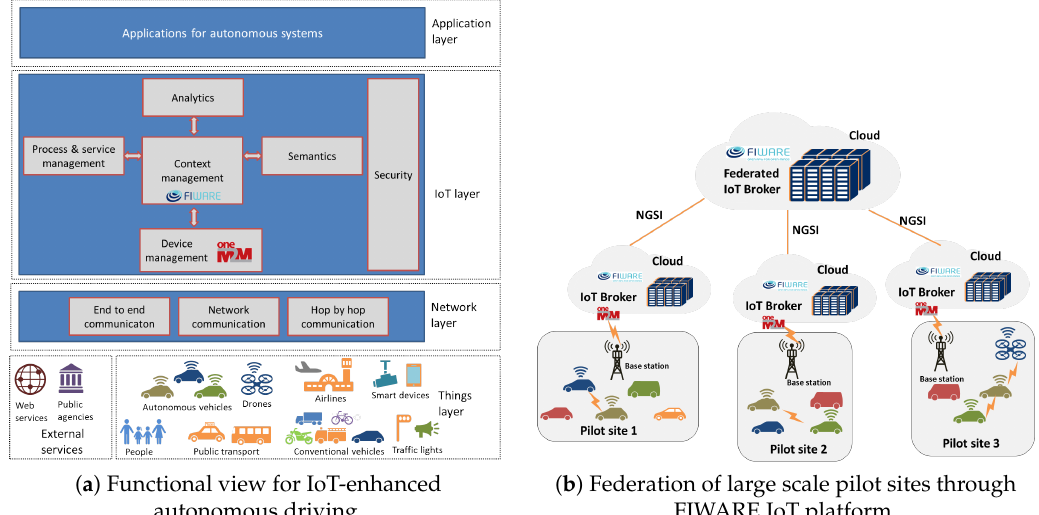
Figure 3. IoT-enhanced autonomous driving.